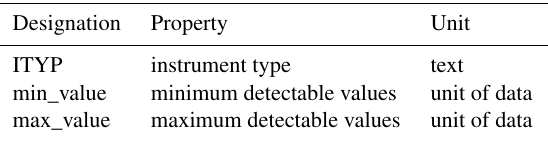
Table 4. Instrumentation.